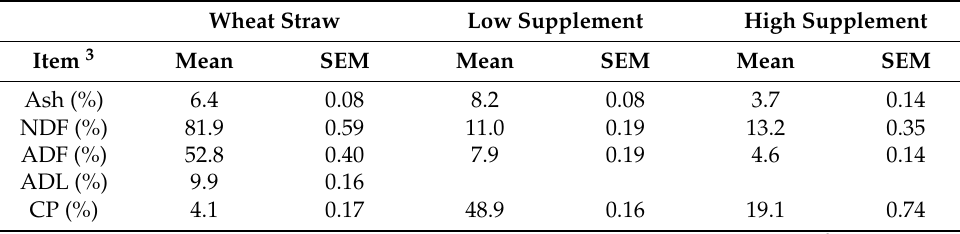
Table 1. Composition of wheat straw and supplements (dry matter basis) 1,2 . Wheat Straw Low Supplement High